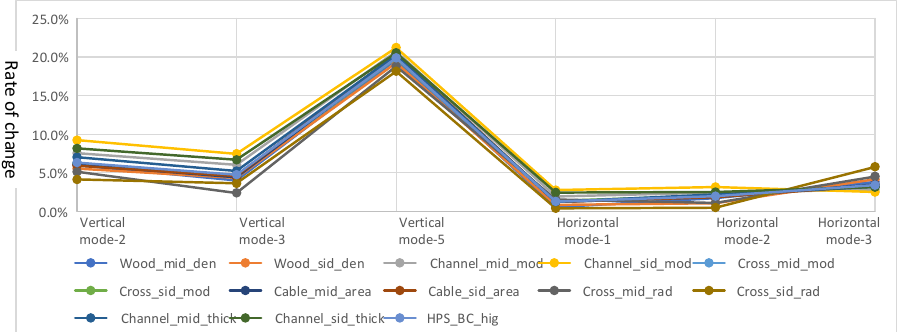
Figure 10. Sensitivity of main parameters measured by six natural frequencies. Note: The density (den), Young’s modulus (mod), area of section (area), thickness of the steel plate (thick), radius of cables (rad), and height of the section (hig) of different parts of the bridge model were tested. The structure from middle 1/3 span is named as ‘mid’; The rest parts are named as ‘sid’; The beams between towers are named as ‘HPS_BC’. Wood is the bridge deck; Channel is the side steel beam of the bridge; Cross is the X brace between side beams; Cable is the main cable of the suspension bridge.